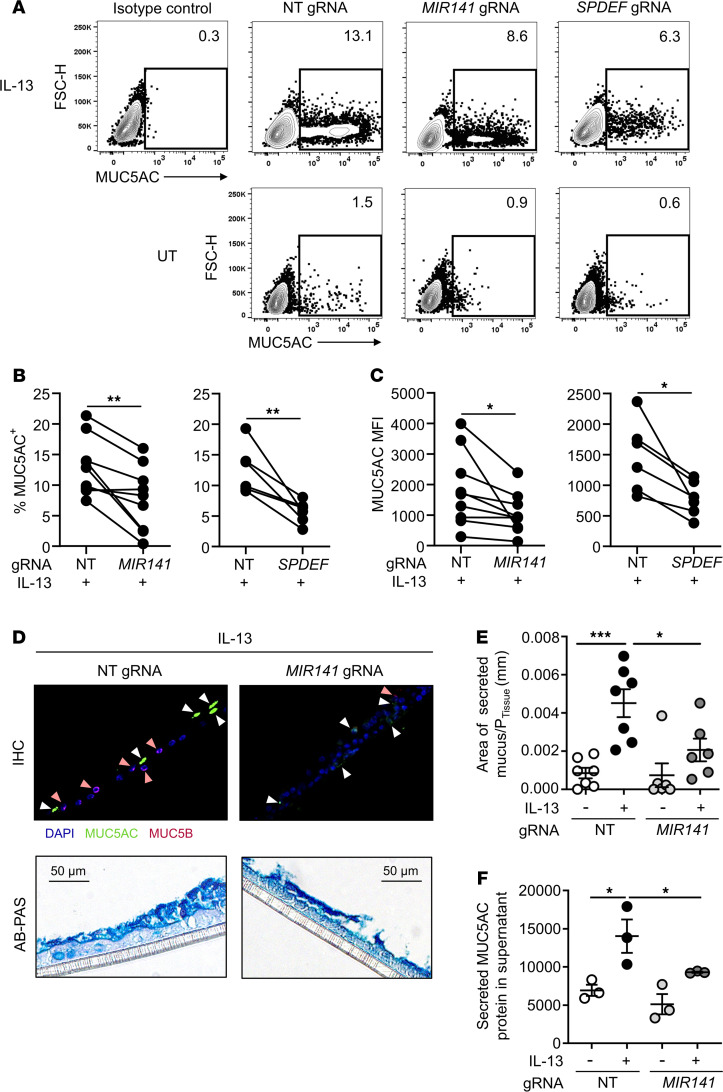
CRISPR/Cas9 targeting of miR-141 reduces IL-13–induced mucus.(A) Representative contour plots demonstrating MUC5AC+ cells in ALI-cultured human bronchial epithelial cells (HBECs) stimulated with (top panel) or without IL-13 (untreated controls; UT) (bottom panel) that have undergone gene editing with nontargeting (NT), MIR141, or SPDEF gRNAs. (A–C)Analysis was performed by intracellular flow cytometry (gated on forward scatter, FSC, singlets). Paired analysis of MUC5AC+ cells (% of all HBECs) (B) and MUC5AC mean fluorescent intensity (MFI) (C) (n = 9, 2-tailed paired t test, *P < 0.05, **P < 0.01). (D) HBEC filter sections stained with fluorescent antibodies for MUC5AC and MUC5B (top panel, positive staining indicated by white and pink arrows, respectively) and Alcian Blue-Periodic Acid Schiff (AB-PAS) (bottom panel). Scale bar: 50 μm. (E and F) Quantification of mucus-producing cells in AB-PAS–stained HBEC filter sections (E) and secreted MUC5AC assessed by dot blot analysis of apical wash (F) from ALI-cultured HBECs following NT or MIR141 gRNA delivery (n = 3–7/group, 1-way ANOVA followed by the Holm-Sidak test; *P < 0.05, ***P < 0.001).